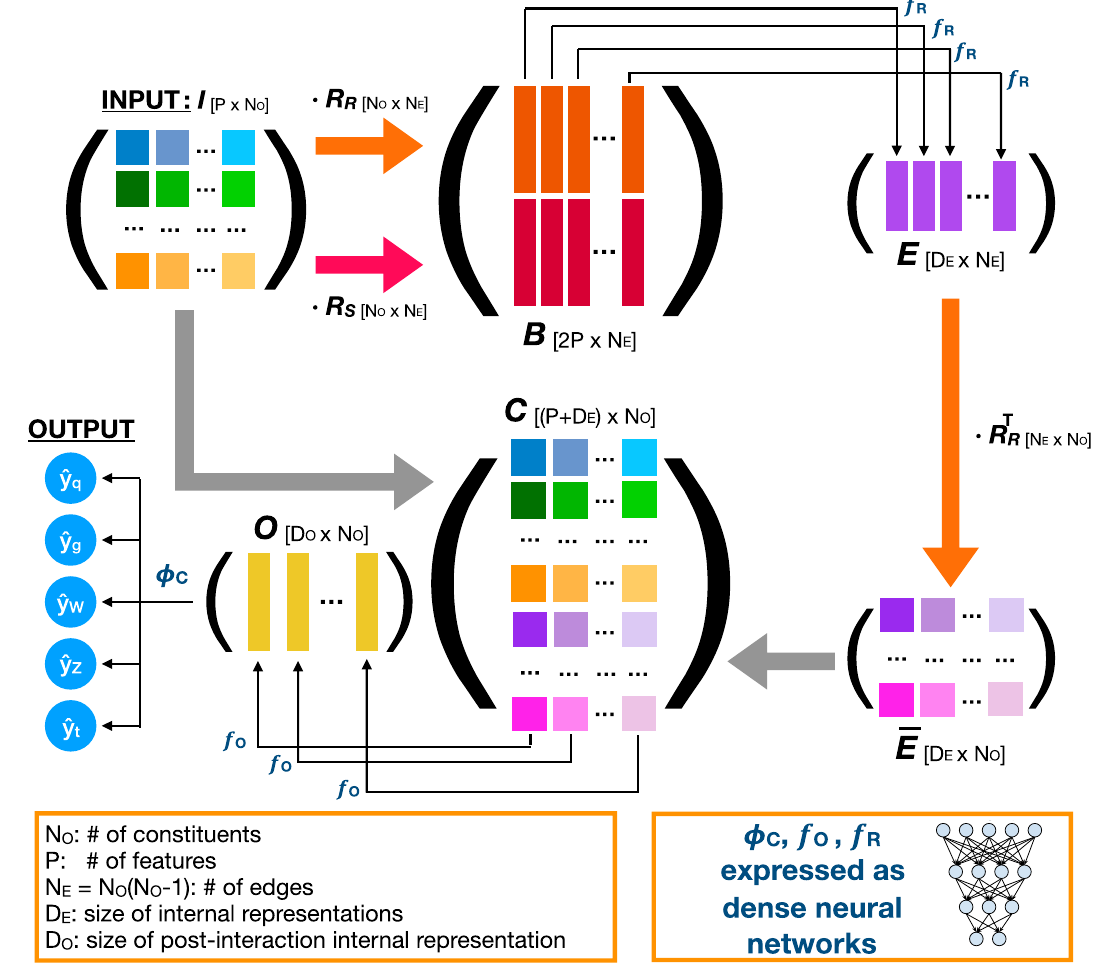
Fig. 7 A flowchart illustrating the interaction network